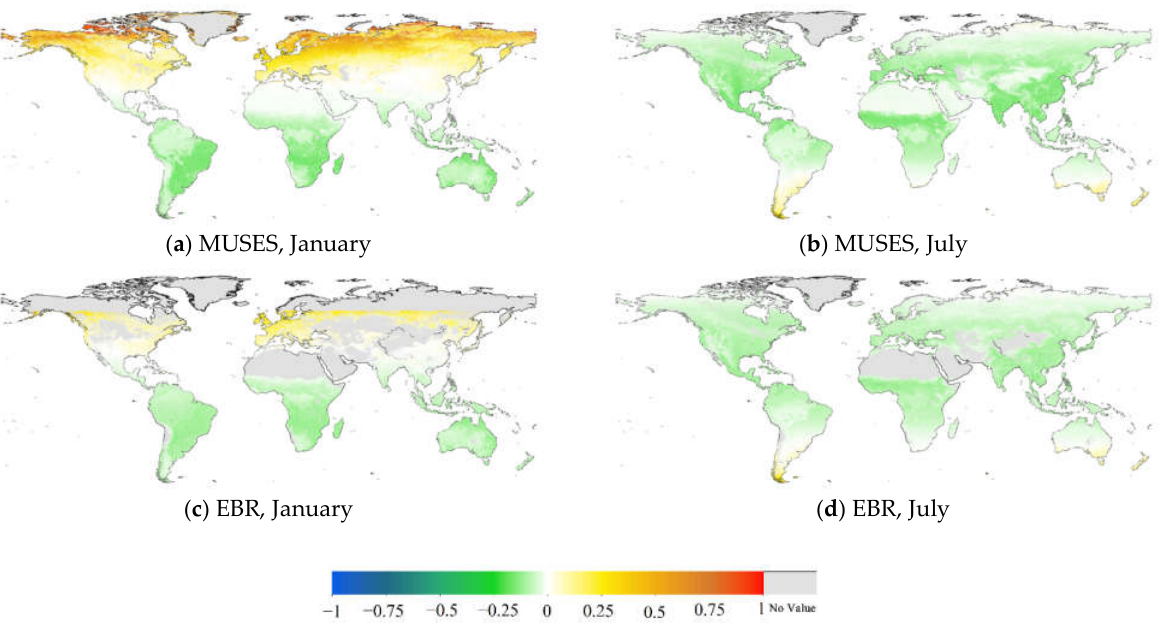
Figure 3. Global maps of differences between black-sky and white-sky FAPAR values of MUSES (top) and EBR (bottom) products in January (left) and July (right) of 2016. ( a ) MUSES, January . ( b ) MUSES, July . ( c ) EBR, January . ( d ) EBR, July .